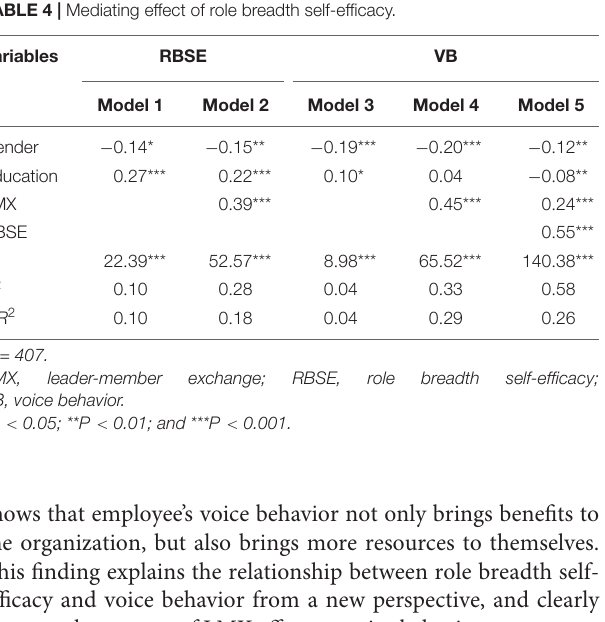
TABLE 4 | Mediating effect of role breadth self-efficacy. TABLE 5 | Moderating effect of perceived